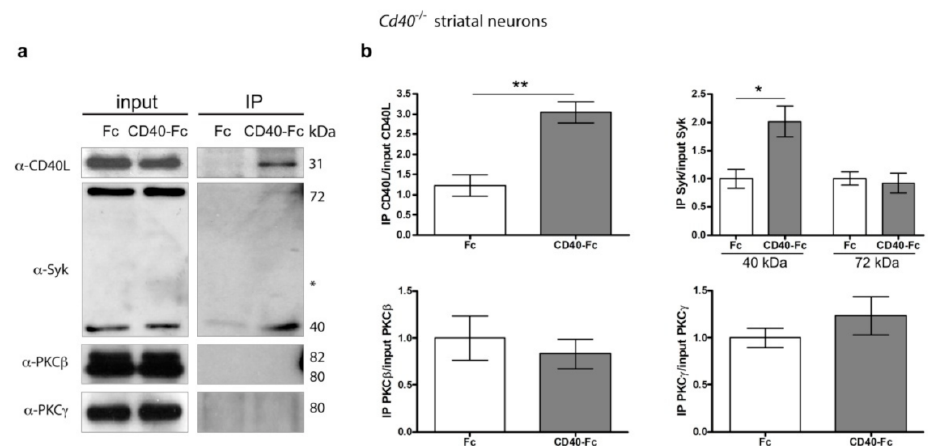
Figure 7. Pull down of Syk in Cd40 − / − striatal MSNs after CD40-activated CD40L reverse signalling. ( a ) Representative western blots of the expression of CD40L, Syk, PKC β , and PKC γ in Cd40 − / − neurons from E14 embryos cultured for 9 days and treated for 30 min with either 1 µ g/mL Fc or 1 µ g/mL CD40-Fc, before pulled-down Fc fragment (input) and after pulled-down Fc fragment (IP). * = nonspecific band. ( b ) Quantification of at least three independent western blots of the quantity of CD40L, 40 kDa Syk, 72 kDa Syk, PKC β , and PKC γ after IP normalizing to the total quantity of those proteins in the input. T-test: ** p < 0.01 and * p <